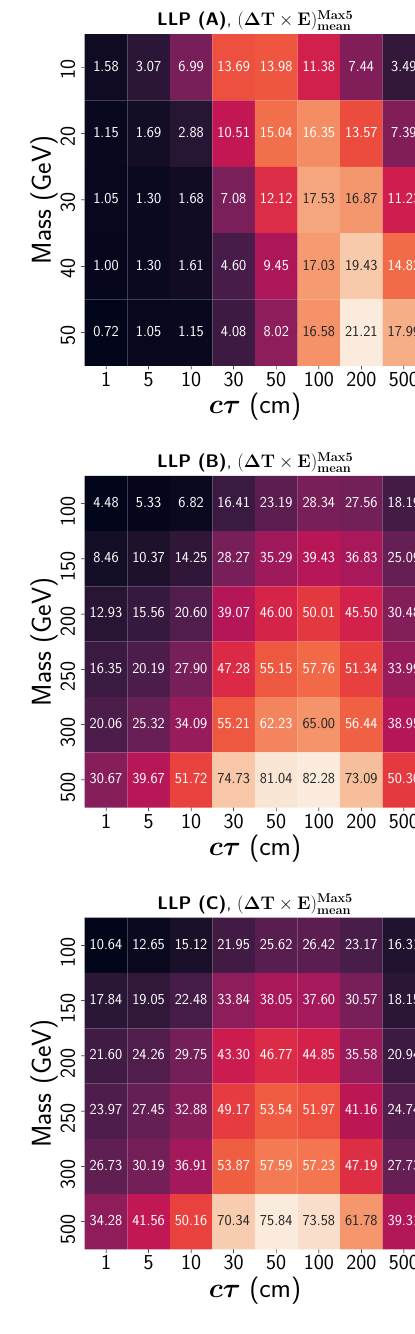
( left ) and (∆ T × E ) max 5 mean mean , respective timing variables, and T